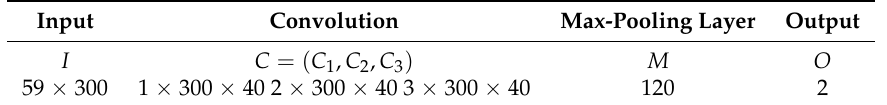
Table 1. CNN architecture. Symbols for each layer are specified in the second row and sizes in the last.